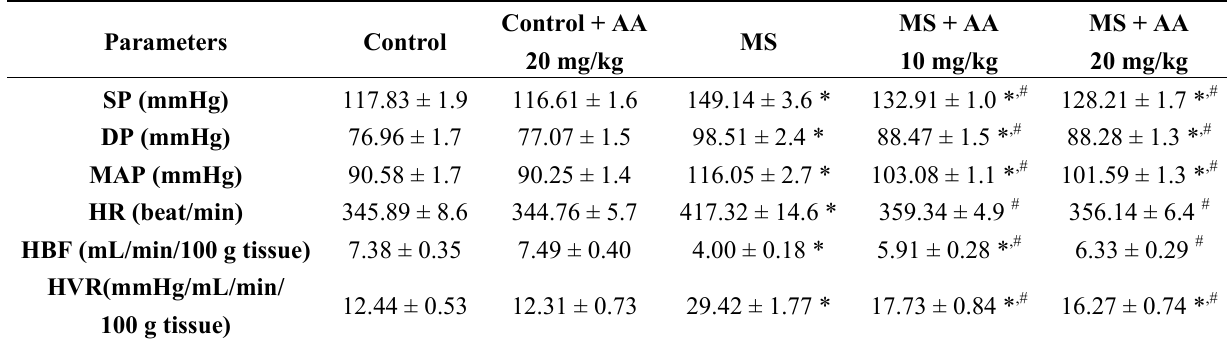
Table 2. Changes in hemodynamic parameters in all experimental groups. Results are expressed as mean ± SEM. AA represents asiatic acid. * p < 0.05 vs . control group, # p < 0.05 vs . MS group ( n =